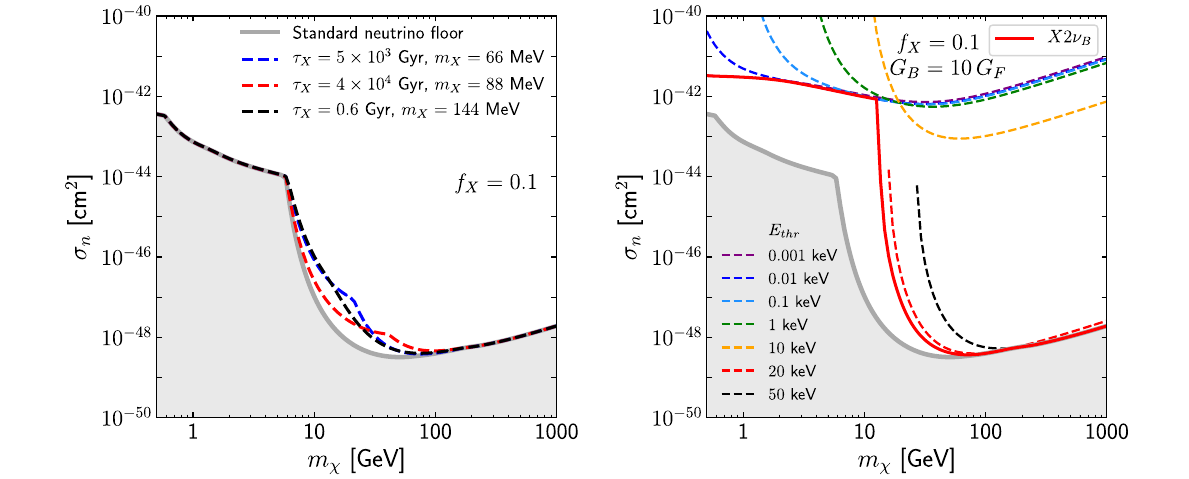
Fig. 7 The DM exclusion potential in the presence of DR in form of result without DR. The various dashed lines show the limits for varying SM neutrinos for various exemplary currently allowed combinations of threshold energy for DR. The thick blue (red) curve as the minimum of ( m ,τ ) in the left panel and for ν = 60MeV, τ = 10 Gyr all curves is the modified neutrino X X B with m X X and G B = 10 G F in the right panel; the gray region shows the standard